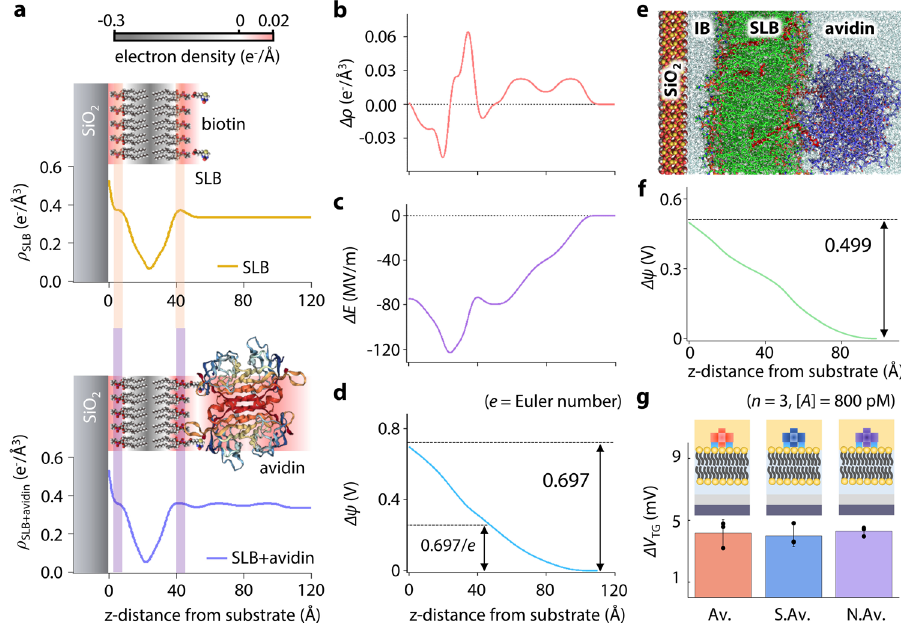
Fig. 4 Redistribution of the electron density in the SLB upon biotin – avidin bindings. a Electron density pro fi les before and after biotin – avidin bindings. b Electron density difference ( Δ ρ = ρ SLB + avidin − ρ SLB ). c Electric fi eld change. d Chemical potential difference upon biotin – avidin binding. e MD simulation of the SLB under avidin binding. The DOPC lipids, B-PE lipids, avidin, and water molecules are colored in green, red, purple, and cyan, respectively. f Induced potential difference upon biotin – avidin binding obtained from MD simulation (see Supplementary Note 11 for details). g Sensor responses to different analytes at identical concentrations. (Av. avidin, S.Av. streptavidin, and N.Av. neutrAvidin). The measurement values represent the mean ± SD for n = 3 independent experiments. Source data are provided as a Source Data fi le. Table 1 Comparison of FET sensors for molecule detection. SLB? Solvent type & conc.